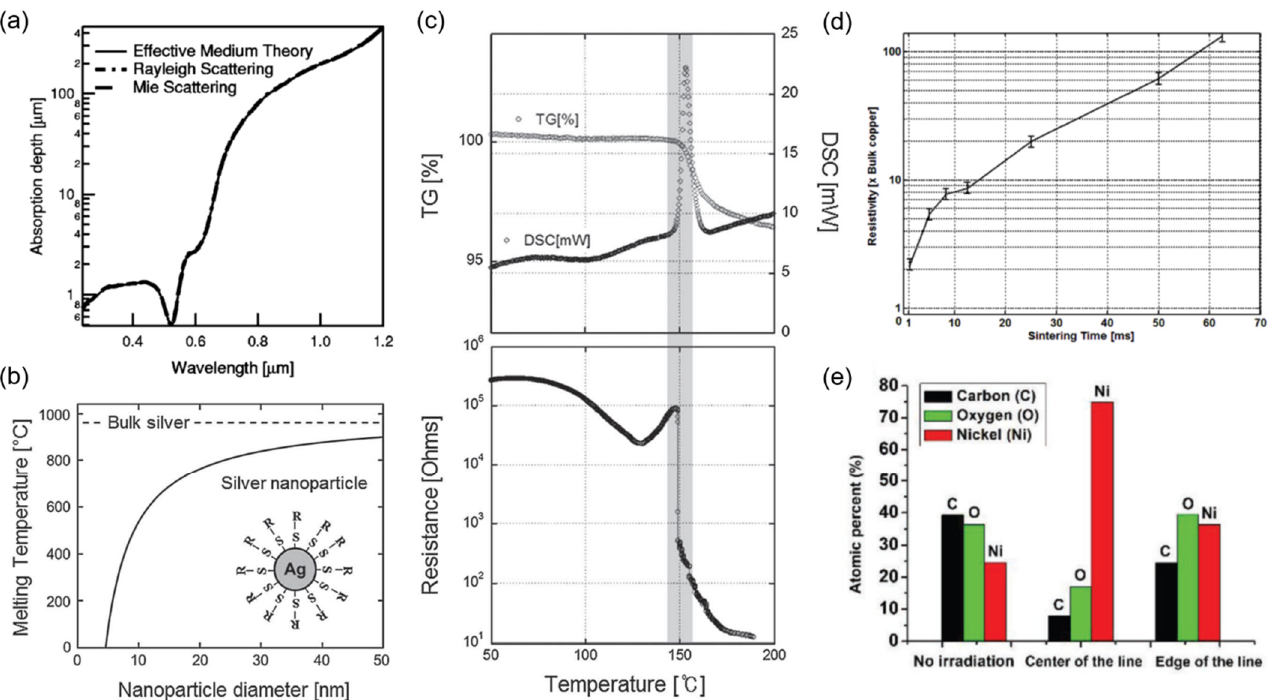
Figure 1. ( a ) Theoretical absorption depth of Au NPs at 5-nm diameter. Reprinted with permission from Ref. [13]; 2003 American Institute of Physics; ( b ) Melting temperature of Ag NP according to diameter calculated from the Gibbs-Thomson equation. ( c ) TGA and DSC measurements of the Ag NP ink at ~5 nm diameter. Reprinted with permission from Ref. [14]; 2011 Wiley-VCH Verlag GmbH & Co. KGaA, Weinheim, Germany; ( d ) Minimum resistivity of laser-sintered Cu electrodes depending on the sintering time. Reprinted with permission from Ref. [15]; 2014 IOP Publishing Ltd., Bristol, UK; ( e ) Chemical composition of NiO NP layer before and after the laser reductive sintering. Reprinted with permission from Ref. [16]; 2019 Wiley-VCH Verlag GmbH & Co. KGaA, Weinheim, Germany.